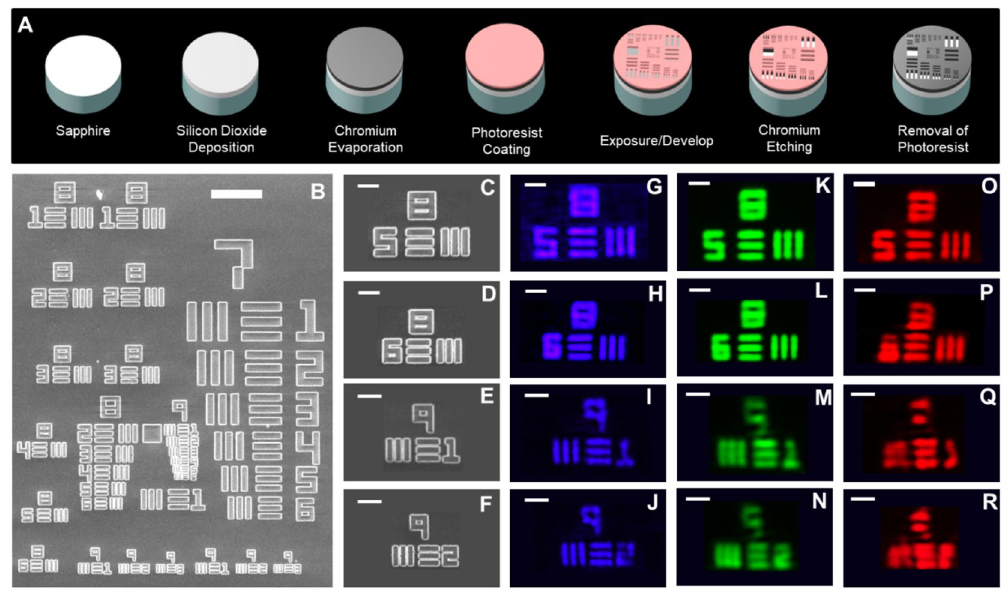
Figure 5. Imaging with the metalens. ( A ) Fabrication of the 1951 USAF resolution test chart. ( B ) SEM micrograph of the fabricated 1951 USAF resolution test chart. Scale bar: 25 μm. ( C – F ) SEM micrographs of the USAF element. ( C ) Group 8 element 5, ( D ) Group 8 element 6, ( E ) Group 9 element 1, and ( F ) Group 9 element 2. ( G – R ) Corresponding Images of the USAF elements formed by the metalenses at laser wavelengths of ( G – J ) 405, ( K – N ) 532, and ( O – R ) 633 nm. Scale bar, 5 μm in ( C – R